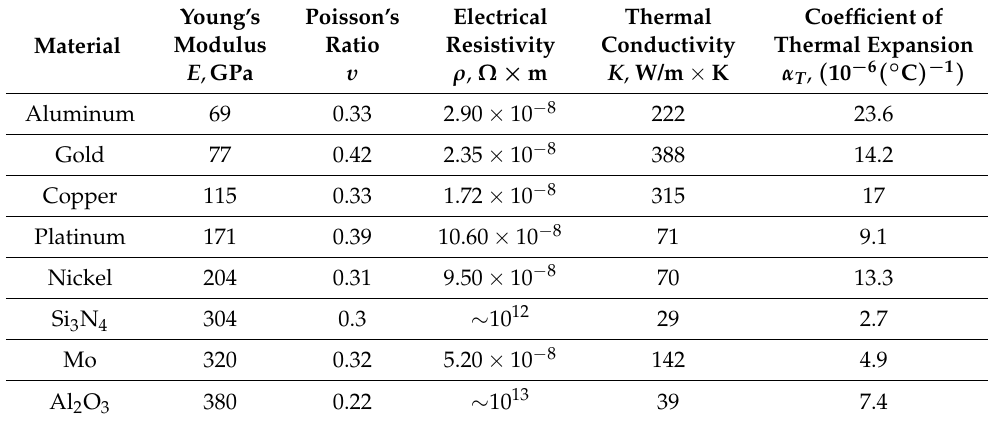
Table 3. The main parameters for choosing the material of the movable mechanical structures. Young’s Poisson’s Electrical Material